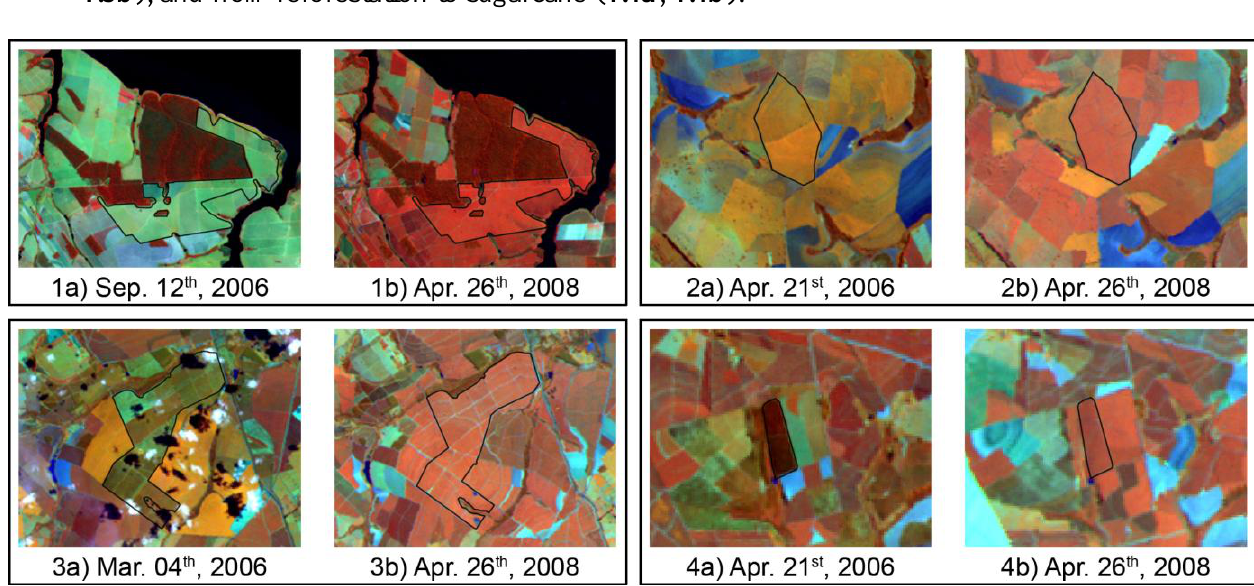
Figure 4. Examples of four different land use conversion: from pasture to sugarcane ( 4.1a , 4.1b ); from agricultural crop to sugarcane ( 4.2a , 4.2b ); from citrus to sugarcane ( 4.3a , 4.3b ); and from reforestation to sugarcane ( 4.4a , 4.4b